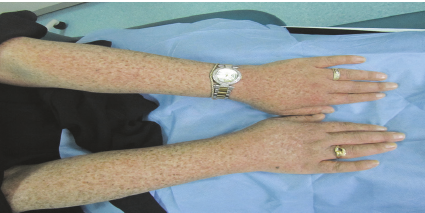
Figure 1: Dyschromatosis symmetrica hereditaria: extensive mixed hypo- and hyperpigmented macules over the dorsal aspect of the upper